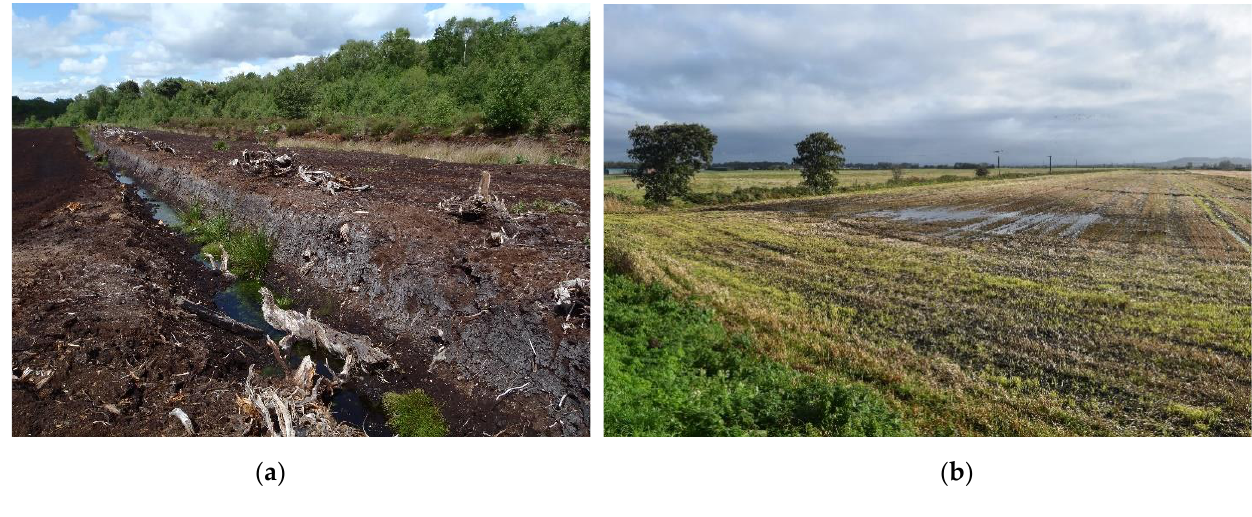
Figure 2. Contrasting preservational environments for subfossil bog-pine in north-west England: a) Lindow Moss, ( a ) former raised peat bog, north Cheshire (image: 6 June 2012), ( b ) a low-lying arable field (5 – 10 m asl) adjacent to Curlew Lane, south-west of Rufford on the Lancashire Coastal Plain. Inland hills (near Parbold) approximately 6 km to the south-east can be seen in the distance (image: 16 October 2019).